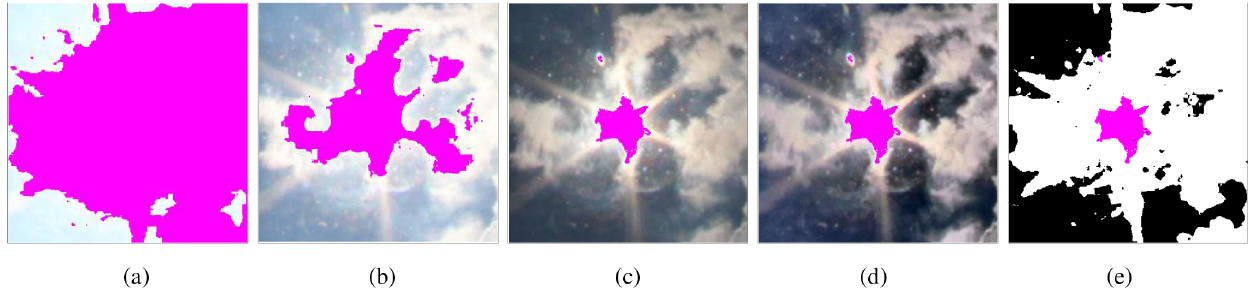
Figure 1. Proposed HDRCloudSeg cloud segmentation approach. (a) High- (b) medium- and (c) low-exposure low-dynamic-range (LDR) images; (d) high-dynamic-range (HDR) image (tone-mapped for visualization purposes); (e) binary output of HDRCloudSeg. Saturated pixels in all images are shown in pink. The number of saturated pixels is significantly reduced in the HDR image, without compromising on the fine cloud